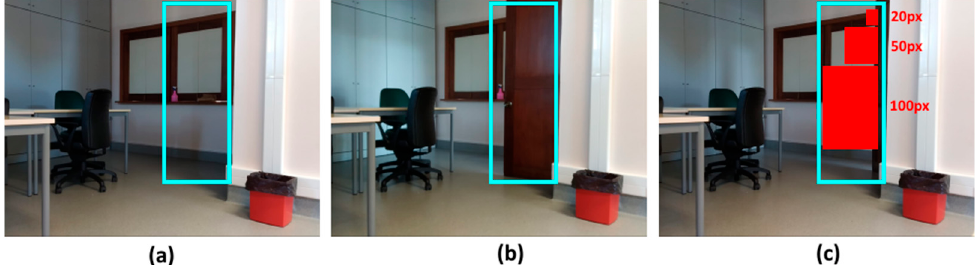
Figure 21. Movement detection of a closed ( a ) and open door ( b ) and the used movement area sizes ( c ).